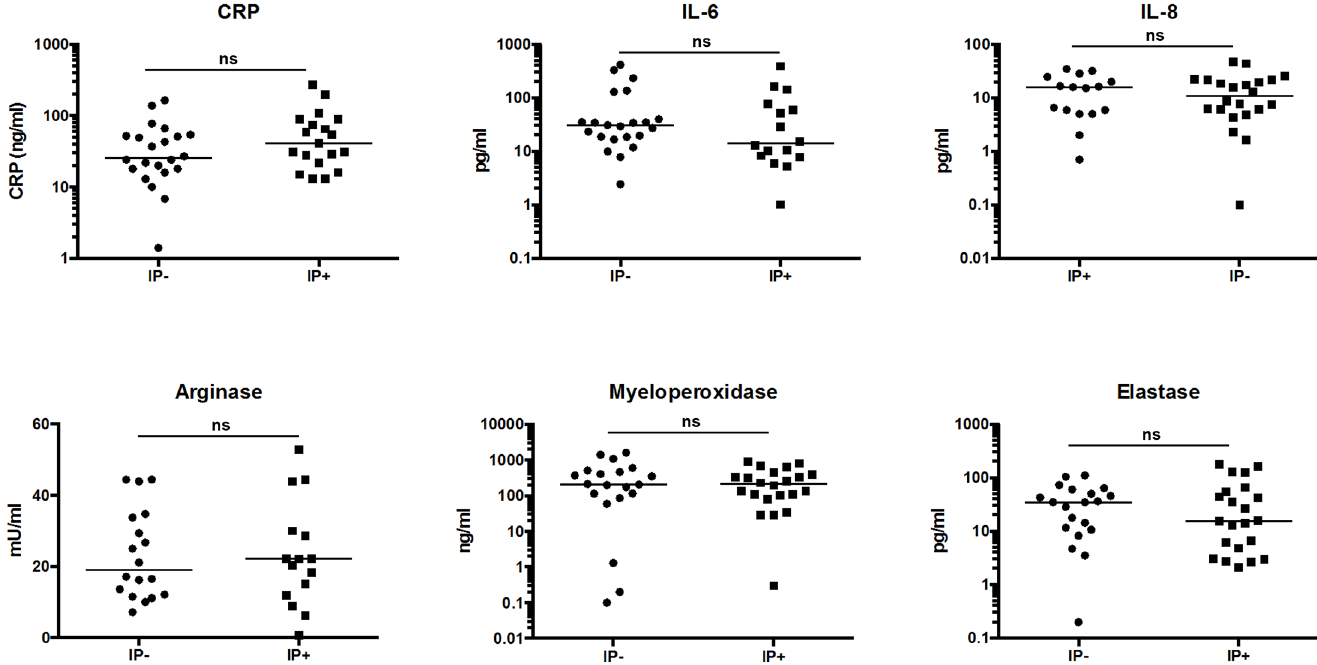
Fig 3. The plasma from VL patients without intestinal parasite co-infections (IP-) and in VL patients co-infected with intestinal parasites(IP+) was tested by ELISA (CRP, IL-6, IL-8, myeloperoxidase and elastase) or enzymatic activity (arginase) as described in Materials and Methods. Statistical significancewas established using a Mann-Whitney test, ns = not significant( p < 0.05).